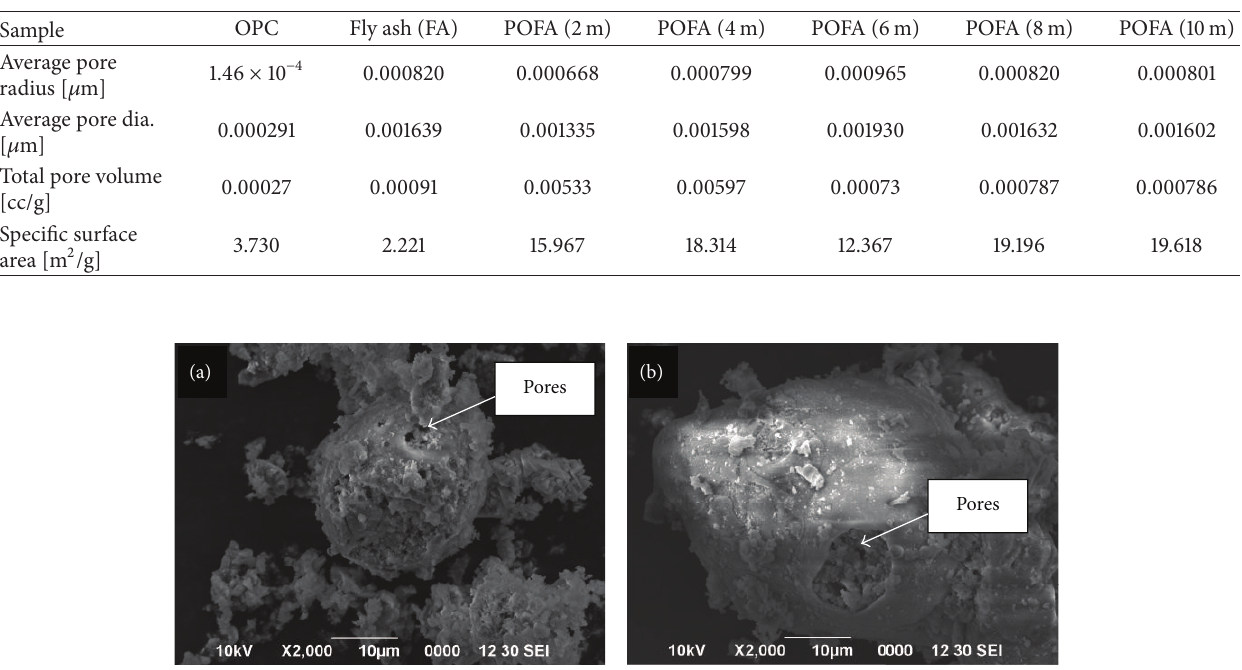
Table 2: Size of sample from BET N 2 test.